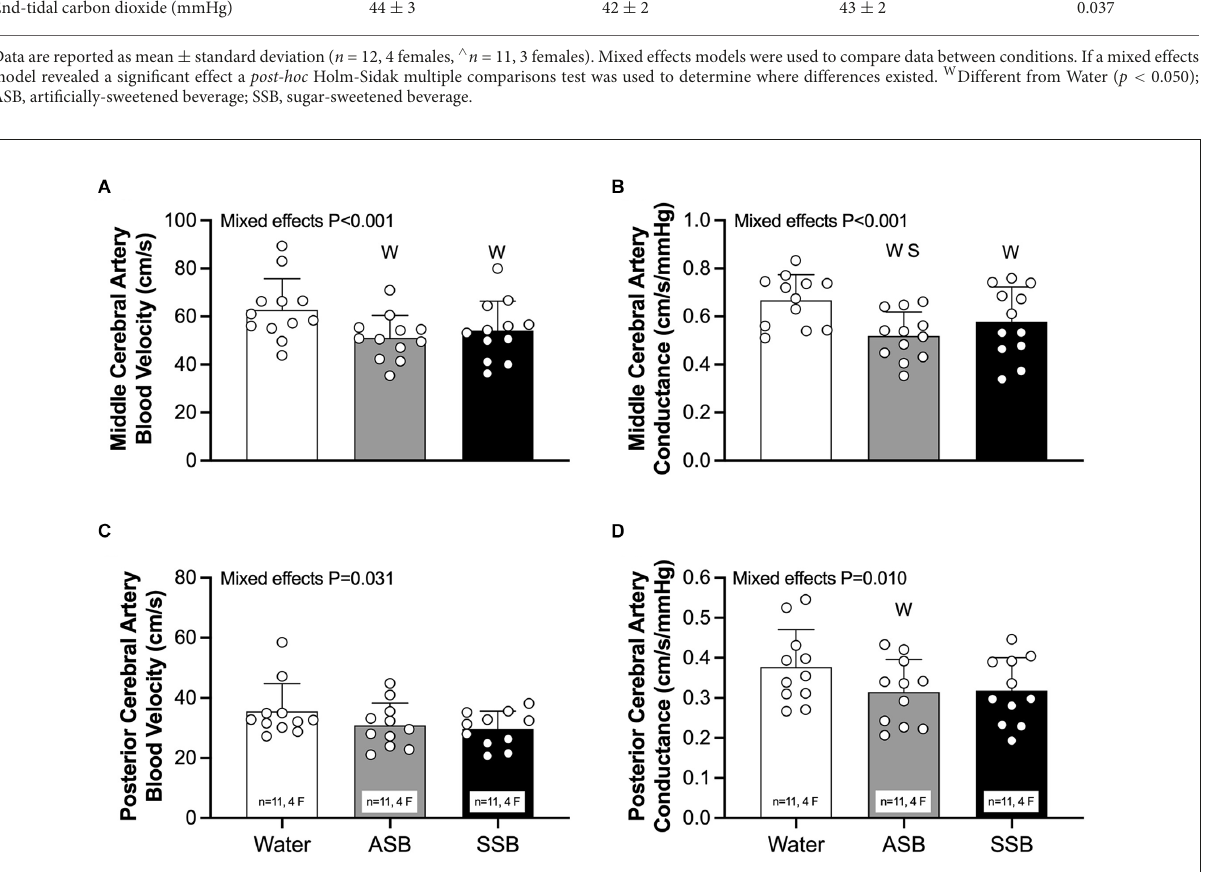
FIGURE2 Seated baseline values 20 min after consuming each experimental beverage for middle cerebral artery blood velocity (A) , middle cerebral artery vascularconductance (B) ,posteriorcerebralarterybloodvelocity (C) ,andposteriorcerebralarteryvascularconductance (D) .Dataarereportedas mean ± standard deviation. Mixed effects models were used to compare data between conditions. If a mixed effects model revealed a significant effect, a post-hoc Holm-Sidak multiple comparisons test was used to determine where differences existed. n = 12, four females unless otherwise noted. Missing data occurred due to the loss of signal and/or inability to obtain a quality signal while maintaining the same depth and/or gain with the transcranial Doppler signal. W Different from Water ( P < 0.050); S Different between soft drinks ( P < 0.050); ASB, artificially-sweetened beverage; SSB, sugar-sweetened